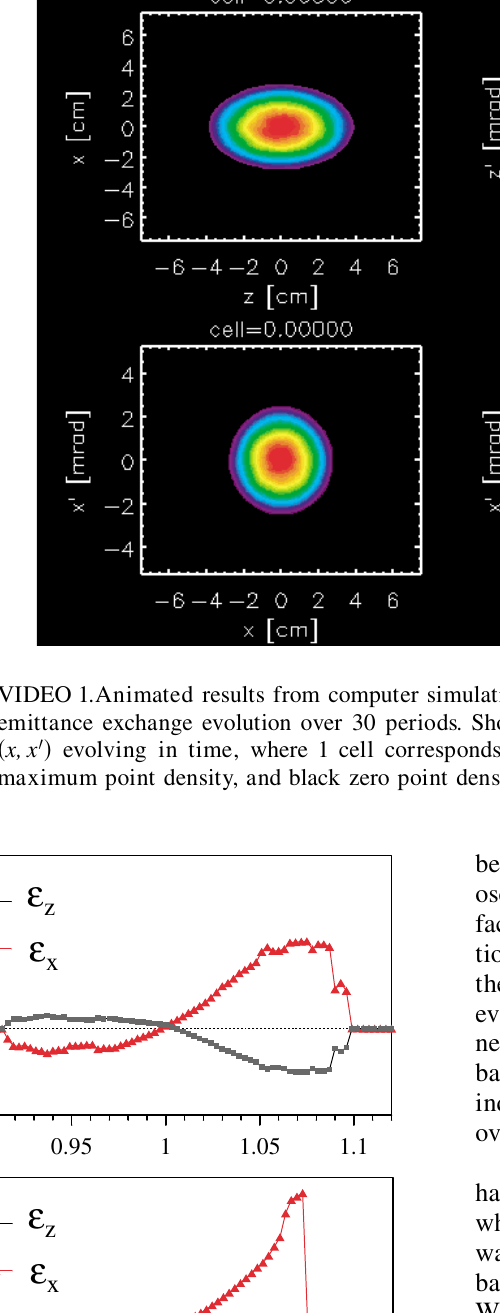
(cid:3) 0 : 8 , (cid:19) (cid:3) 2 ) as functions of the tune =(cid:10) =(cid:19) x z x 0 x